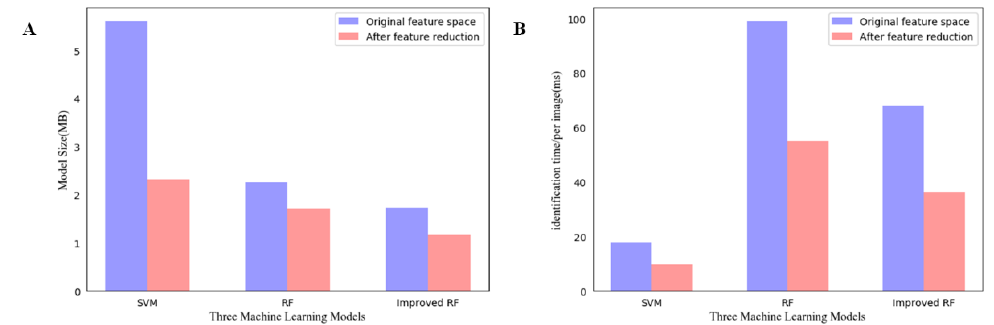
Figure 14. Size comparison of different machine learning models ( A ), random forest ( B ) Comparison of the identification speed of different models for each image.